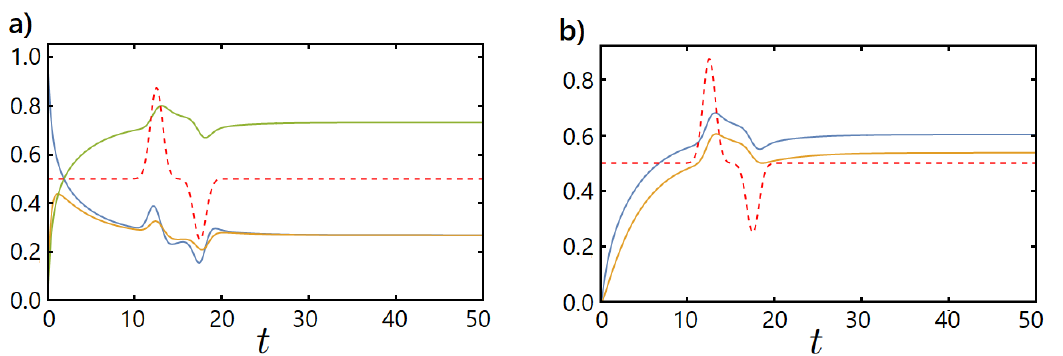
= 0.5 (dashed curve), α = 0.5, γ j